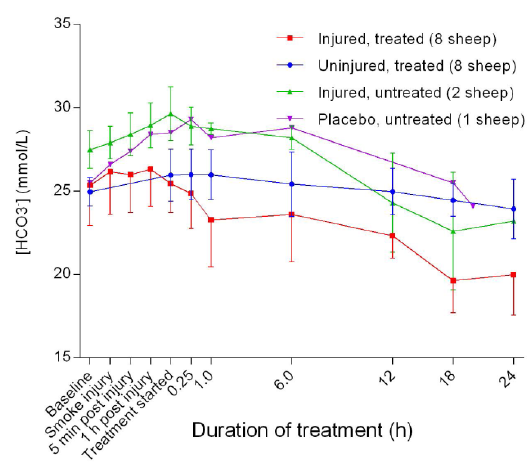
Figure 21. Blood bicarbonate concentration (Mean ± SD) for smoke and non-smoke injured sheep receiving extracorporeal life support alongside untreated controls.